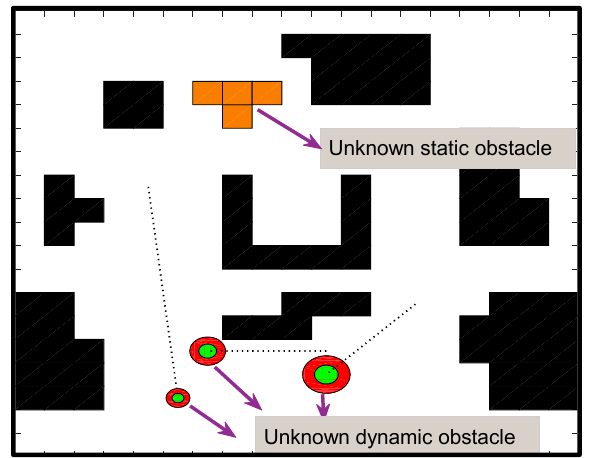
Figure 1. The natural working environment of the robot.